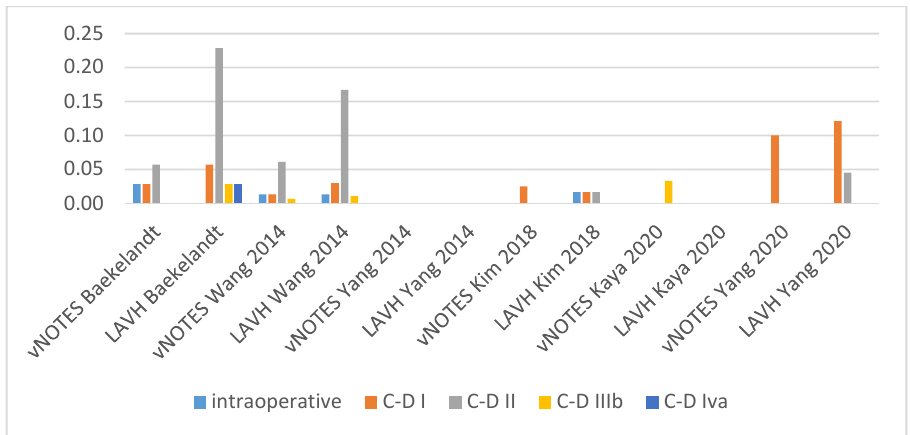
Figure 4. Intra- and postoperative complications (C-D: Clavien–Dindo score).